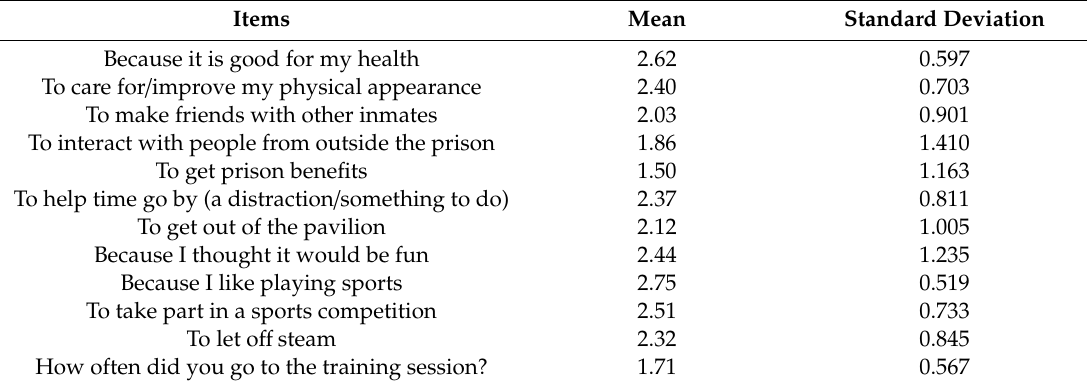
Table 1. Reasons respondents gave for joining the sports program.